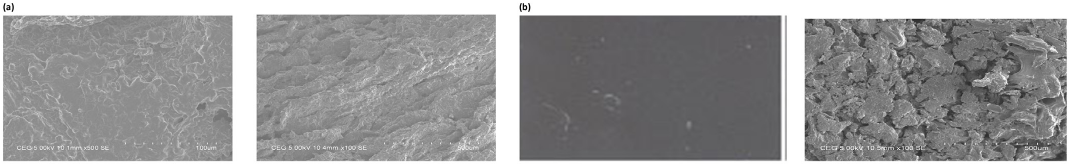
Fig.6a. SEM Micrographs of PBSBT before and after alkaline (0.1N NaOH) degradation; b. SEM Micrographs of PBSeBT before and after alkaline (0.1N NaOH) degradation